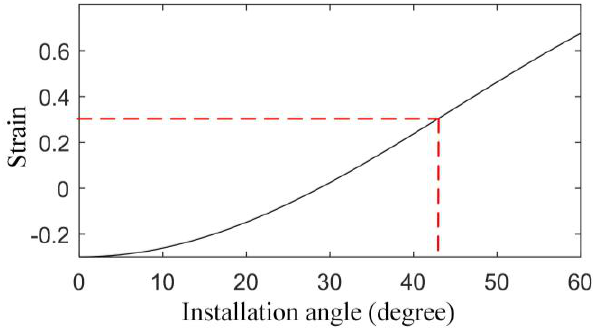
Figure 6. Relationship between the axial strain and the installation angle of the FBG.